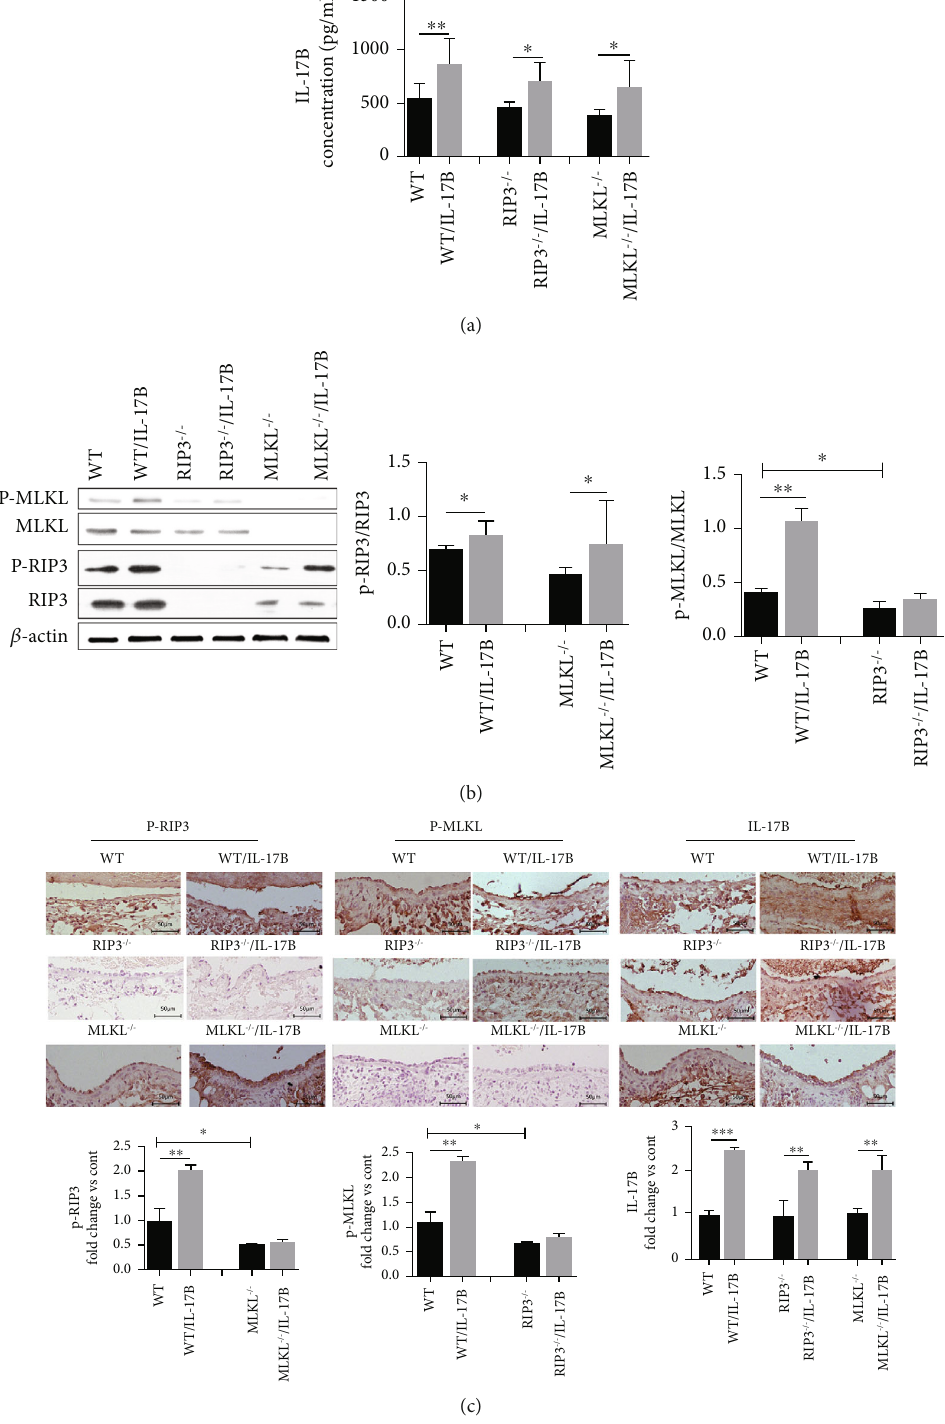
Figure 5: IL-17B accelerates vascular injury by increasing the expressions of RIP3 and MLKL and their phosphorylation. (a) ELISA was used to test the expression of IL-17B in the thrombogenic IVC wall of the WT and knockout mice, and with or without IL-17B interference. (b) Protein expression of RIP3, p-RIP3, MLKL, and p-MLKL in the IVC wall in each group by western blot, with the internal reference of β -actin as the control. The ratio of protein gray value to total protein gray value was analyzed using the ImageJ image software. (c) Immunohistochemistry was used to determine the expression of the p-RIP3, p-MLKL, and IL-17B proteins in each group. The Image-Pro Plus 6.0 software was used to calculate the positive rate. The bar chart shows the ratio of positive expression of the IL-17B protein value to the control group ( n = 6 , scale = 50 μ m, 200x). Six mice were tested in each group. ANOVA was used for statistical analysis. ∗ P < 0 : 05 , ∗∗ P < 0 : 01 , and ∗∗∗ P < 0 : 001